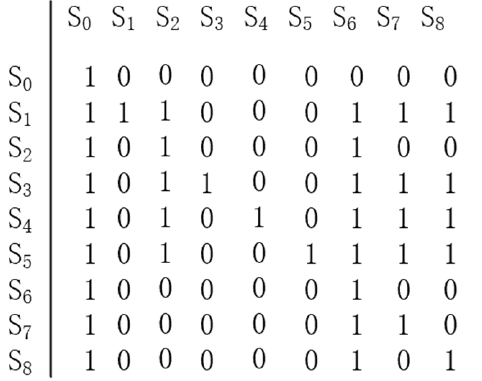
Figure 1. Reachability matrix.